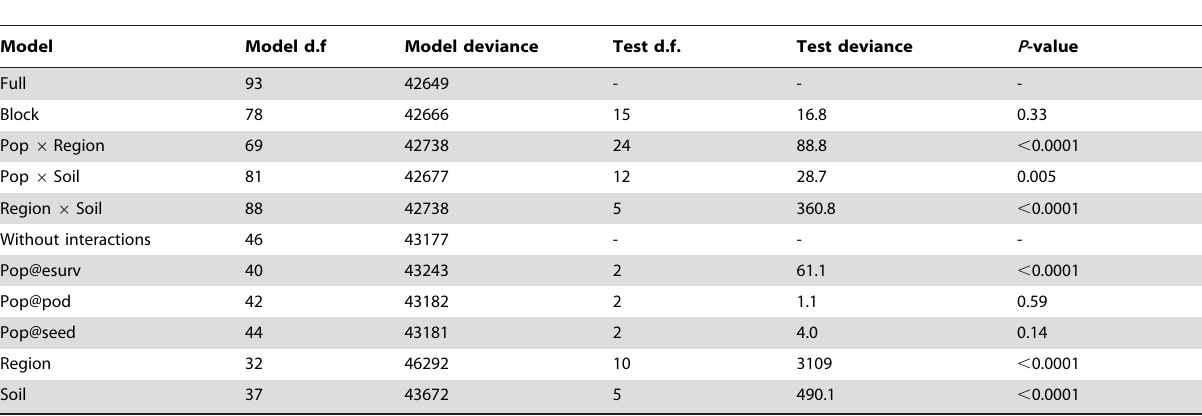
Table 2. Summary of aster model comparisons to test for effects of population, region and soil and all interactions on C. fasciculata lifetime seedpod